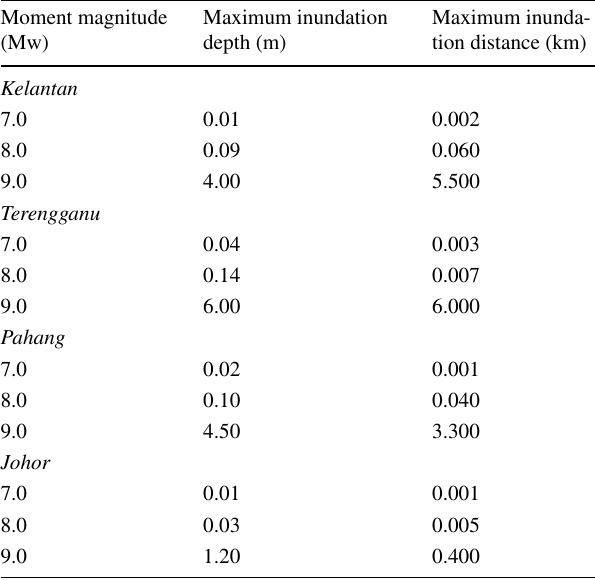
Table 3 Maximum inundation depth and inundation distance at dif- ferent moment magnitudes Moment magnitude